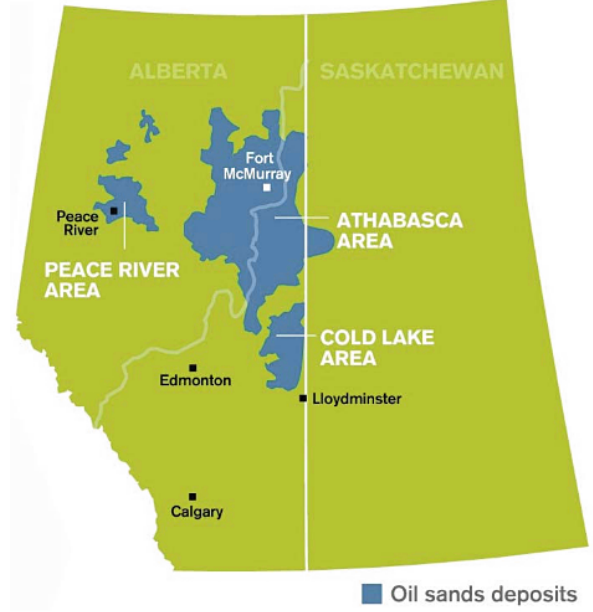
Figure 1. Alberta’s oil sands deposits in the Athabasca, Peace River, and Cold Lake regions (http://www.energy.alberta.ca/oilsands/791.